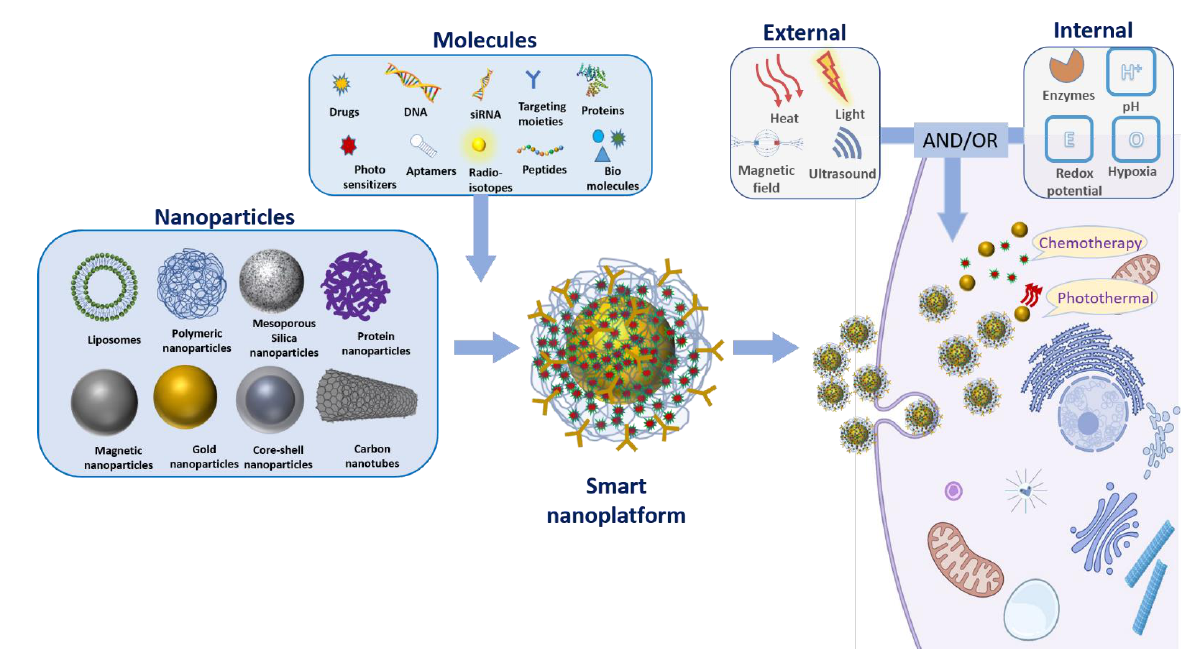
Figure 1. Illustration of the design for smart nanoplatform. This illustration represents various nanoparticles, therapeutic molecules, targeting moieties, and different types of internal or external stimulus that are commonly used to design smart nanoparticles. For instance, gold nanoparticles can be functionalized with therapeutic molecules through a pH sensitive linker. Moreover, these nanoplatforms can be decorated with different targeting moieties such as peptide or antibodies for selective targeting. The acidic pH triggers in tumor cells release the chemotherapeutic agent by cleaving the pH re- sponsive linker (chemotherapy). Furthermore, these gold nanoparticles can be used as a photothermal agent for thermal ablation of cancer cells (photothermal therapy). To summarize, various combinations of nanoparticles, therapeutic and/or targeting molecules, and internal/external stimulus can be employed to design and develop smart nanoplatforms.